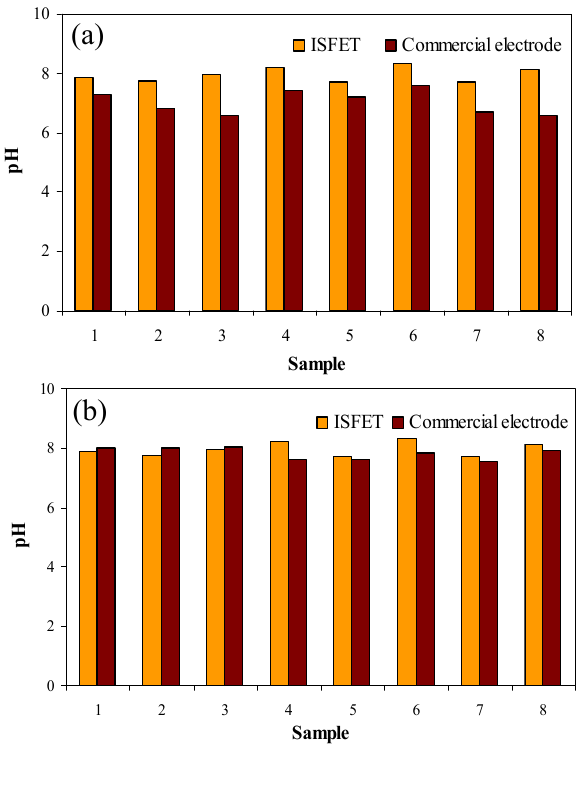
Figure 5. pH-ISFETs values of wastewater samples coming from a winemaking production line and comparison with those performed with a glass electrode. (a) Effluent. (b) Effluent after